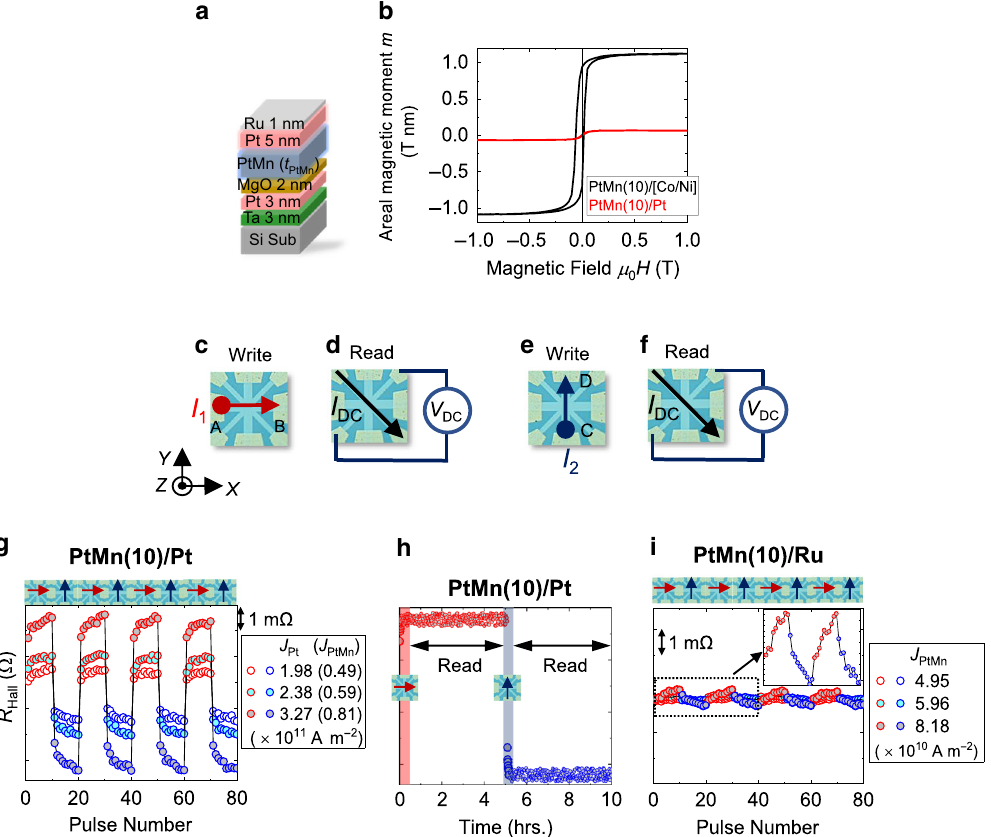
Fig. 1 Stack structure, schematics of measurement con fi guration, and current-induced switching. ( a ) Schematic diagram of the stack structure. ( b ) areal magnetic moment ( m ) vs magnetic fi eld ( H ) for sub./PtMn(10)/[Co(0.3)/Ni(0.6)] 2 /Co(0.3)/MgO(2)/Ru(1) (PtMn(10)/[Co/Ni]) and PtMn(10)/Pt structure. ( c ) – ( f ) Optical micrograph of the star-shaped device structure and schematic diagram of the measurement set-up. Write currents I 1 and I 2 are sourced along the paths from A(C) to B(D), respectively. Reading of the antiferromagnetic states is achieved by measuring transverse Hall voltage ( V DC ) under the application of read current ( I DC ) along the arm aligned at 45° to the write channel. ( g ) Experimental results of current-induced manipulation of PtMn(10)/Pt structure under applied current densities J Pt = 1.98 × 10 11 Am − 2 ( J PtMn = 4.96 × 10 10 Am − 2 ) J Pt = 2.38 × 10 11 Am − 2 ( J PtMn = 5.95 × 10 10 Am − 2 ) and J Pt = 3.27 × 10 11 Am − 2 ( J PtMn = 8.17 × 10 10 Am − 2 ). ( h ) The stability of written states was investigated by measuring R Hall for several hours after writing. Red and blue shaded area corresponds to the writing of PtMn(10)/Pt by 10 write pulses along a direction indicated by the arrows in the schematics. The scale bar of the y-axis ( R Hall ) is same as of ( g ). ( i ) Results of current-induced manipulation of PtMn(10)/Ru structure under applied J PtMn = 4.95 × 10 10 , 5.96 ×10 10 , and 8.18 × 10 10 Am − 2 respectively. Inset shows a magni fi ed view of R Hall vs pulse number characteristics for J PtMn = 8.18 × 10 10 Am − 2 for the area bounded by the rectangular box. Schematic diagrams above ( g ) and ( i ) denotes the sequence of application of I 1 and I 2 in the respective structures.